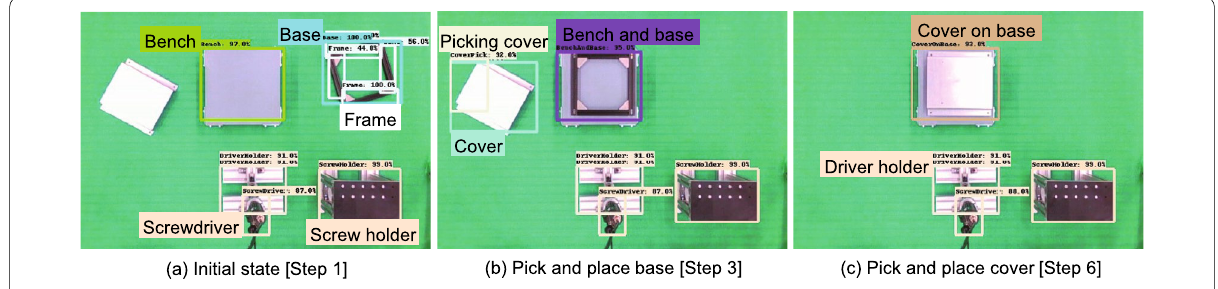
Fig. 7 Task execution result: object labels and states recognized by